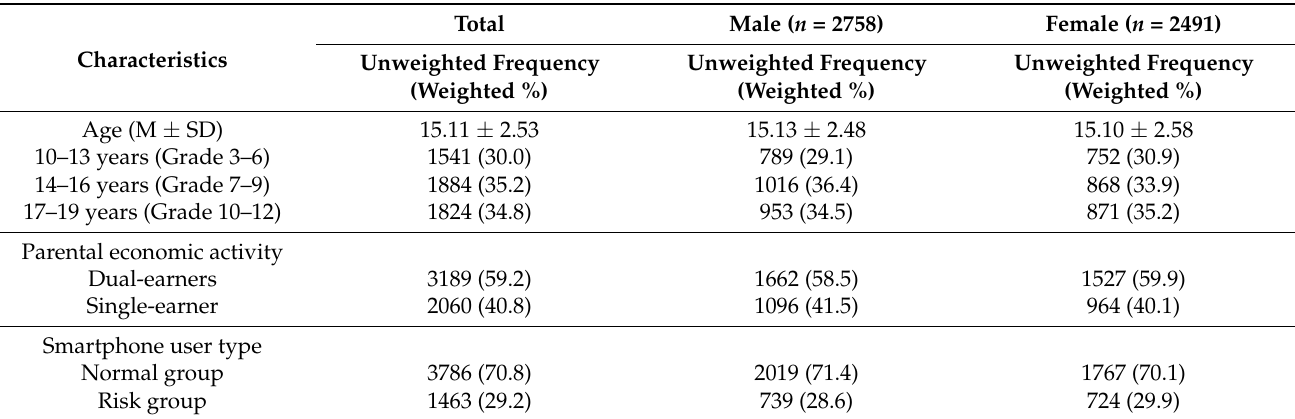
Table 1. Demographics and prevalence of smartphone addiction ( n =